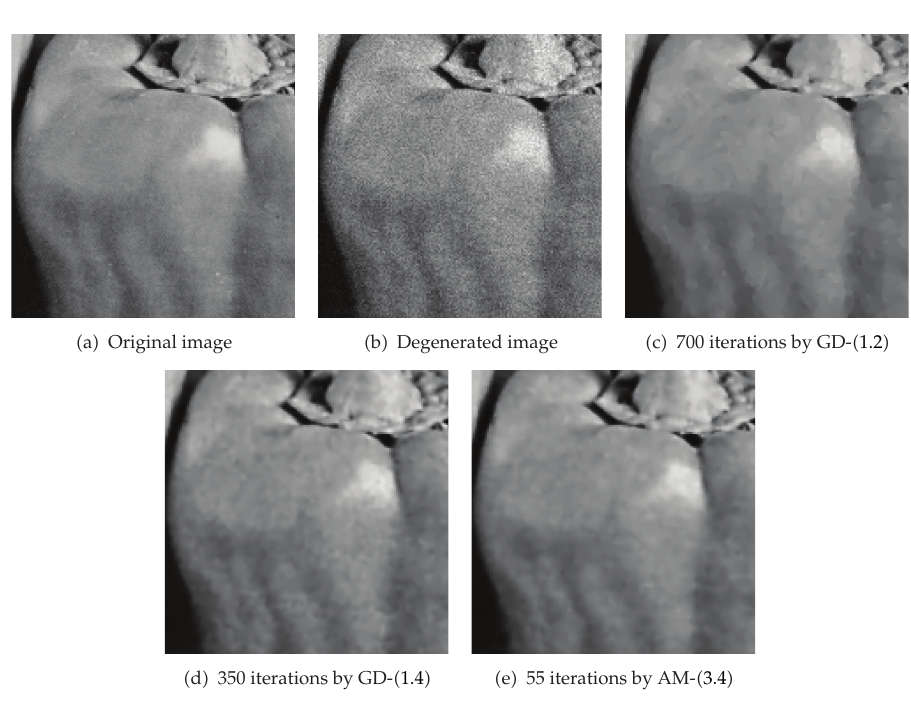
Figure 5: Recovered results by the three methods.